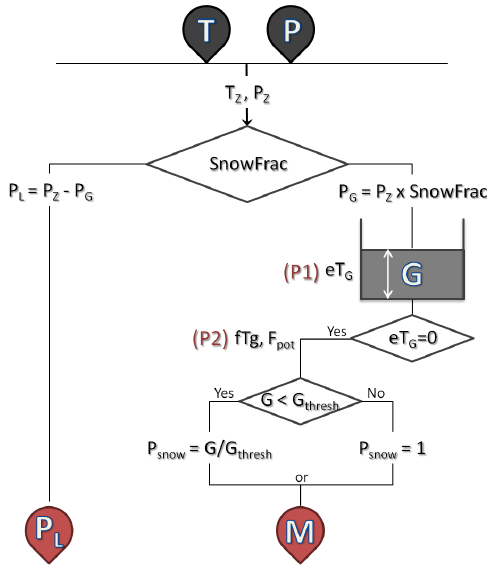
Figure 3. Initial version of the CemaNeige snow module (N1). T is temperature, P is total precipitation, P L is liquid precipitation, P G is solid precipitation, and M is snowmelt. G corresponds to the snowpack and P1 and P2 are the two free parameters (modified from Valéry, 2010).